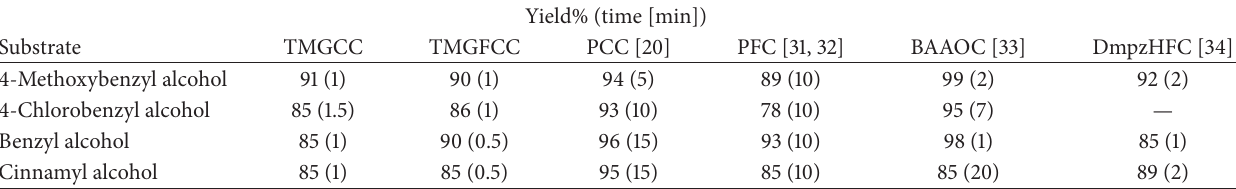
Table 5: Comparison of oxidation of various organic substrates by TMGCC, TMGFC, PCC, PFC, BAAOC, and DmpzHFC. Yield% (time